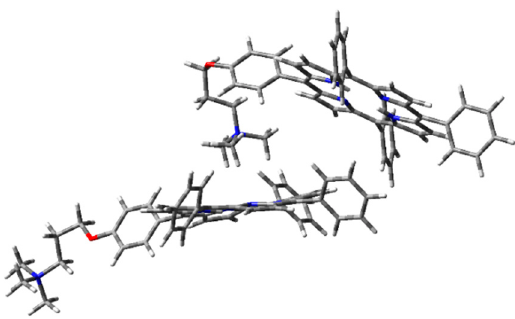
Figure 8. 1H 2 cation– π dimer geometry optimization in the vacuum with CAM-B3LYP functional and